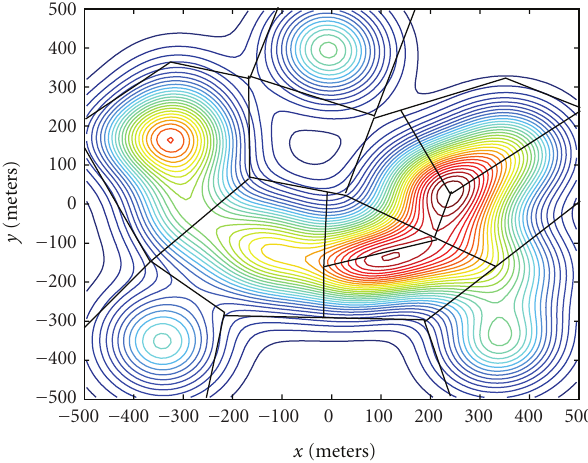
Figure 4: Example partitioning of the surveillance area based on a target density distribution. The target density distribution is represented by contour lines. The boundaries of the partitions are represented by thick, straight lines. The space of this plot represents the surveillance area over which the target density distribution is defined. The particular choice of partitions displayed is of little significance. What is significant is to note that the partitions are determined based on the information content provided by the target density